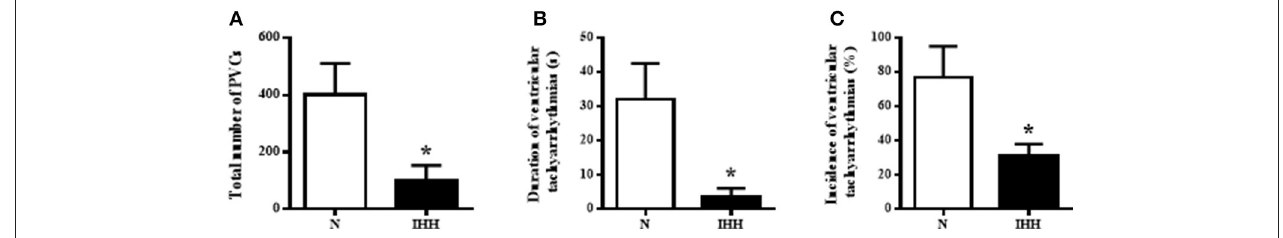
FIGURE 7 | Effect of chronic intermittent hypobaric hypoxia (IHH, black columns) on the incidence of ventricular tachyarrhythmias (tachycardia and fibrillation) (A) , total duration of ventricular tachyarrhythmias (B) and total number of premature ventricular complexes (PVCs) occurring as singles, salvos and tachycardia (C) during 10-min regional ischemia. N, normoxic group (open columns). Values are mean ± SEM, ( n = 13 in each group), * P <